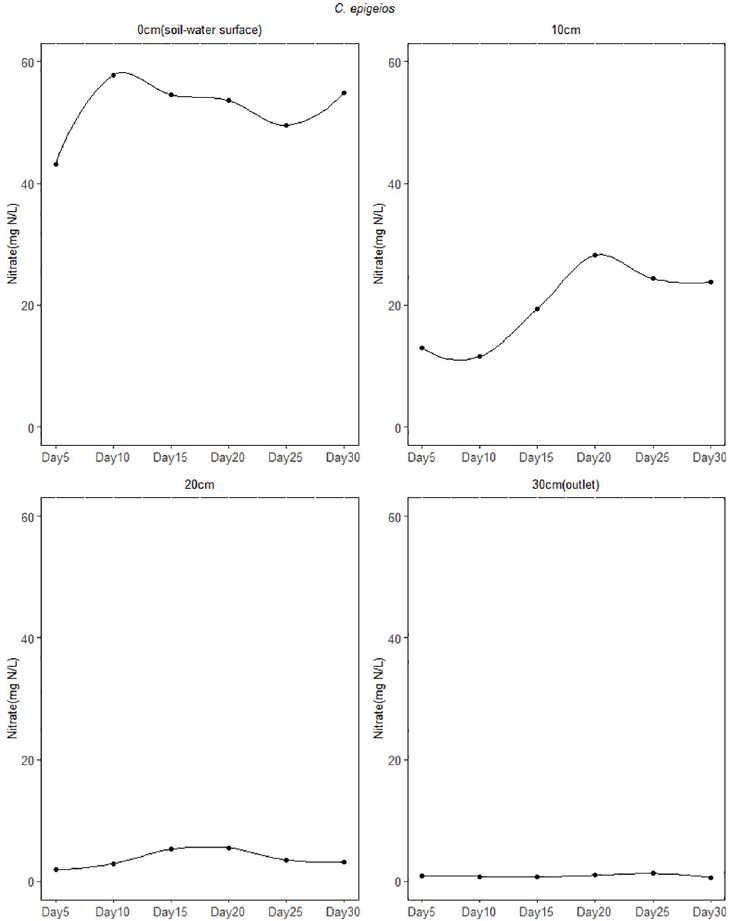
Fig 7. Temporal variation of NO (cid:0) C . epigeios